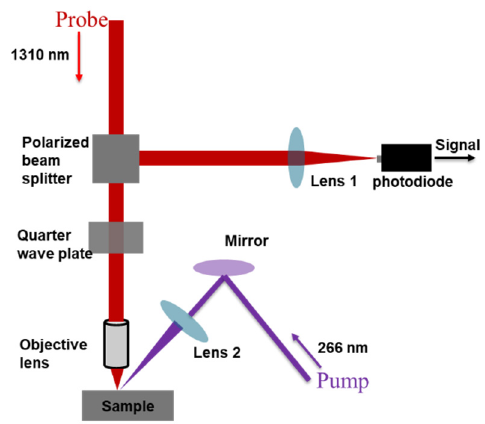
Figure 8. The schematic of the experiment setup.